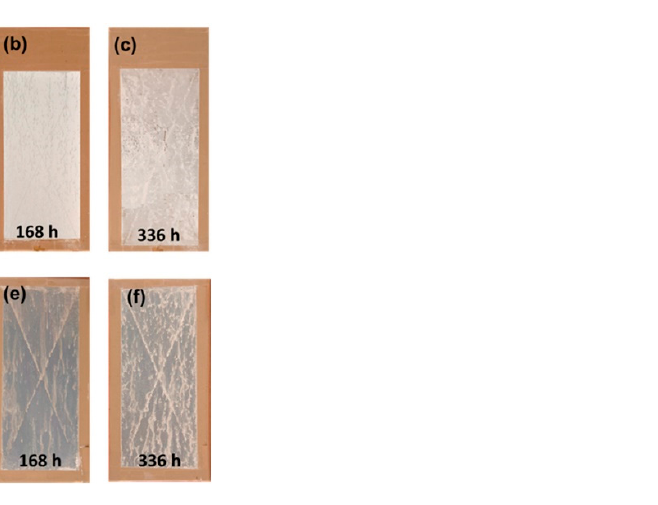
Figure 8. Corrosion resistance performance of AA2024, ceria nanofiber, and commercial ceria in the salt spray studies for sol-gel ( a – c ) and CCC ( d – f ) coating materials after 168 h and 336 h [85]. Table 3. Studies on the corrosion resistance using hybrid sol-gel coating on steel